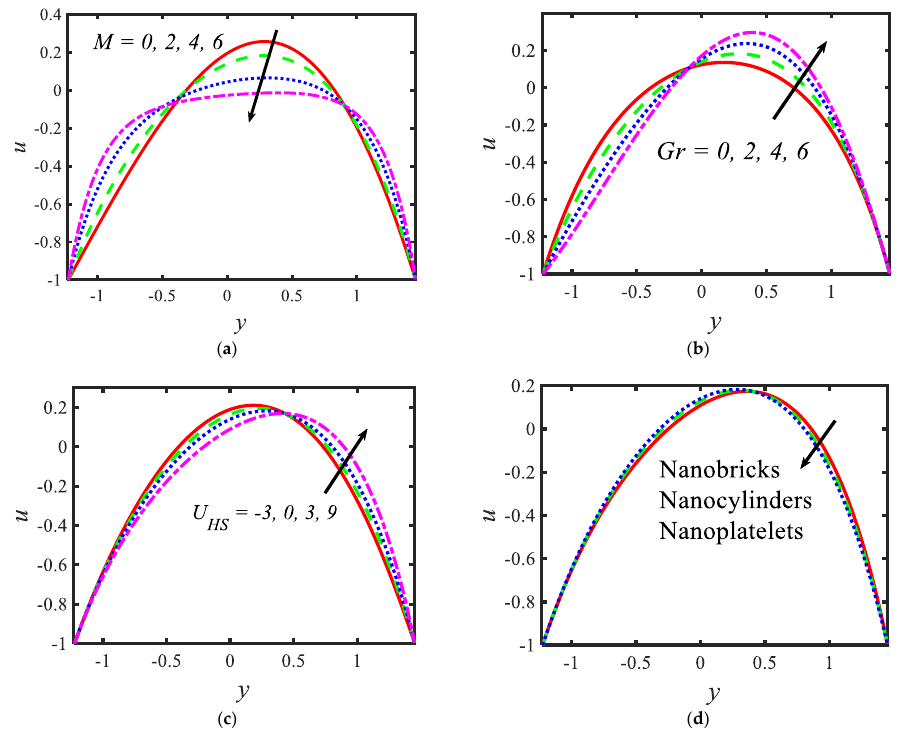
Figure 3. Variations in the velocity profiles for ( a ) the Hartmann number, ( b ) Grashof number, ( c ) Helmholtz – Smoluchowski velocity and ( d ) shape factor.